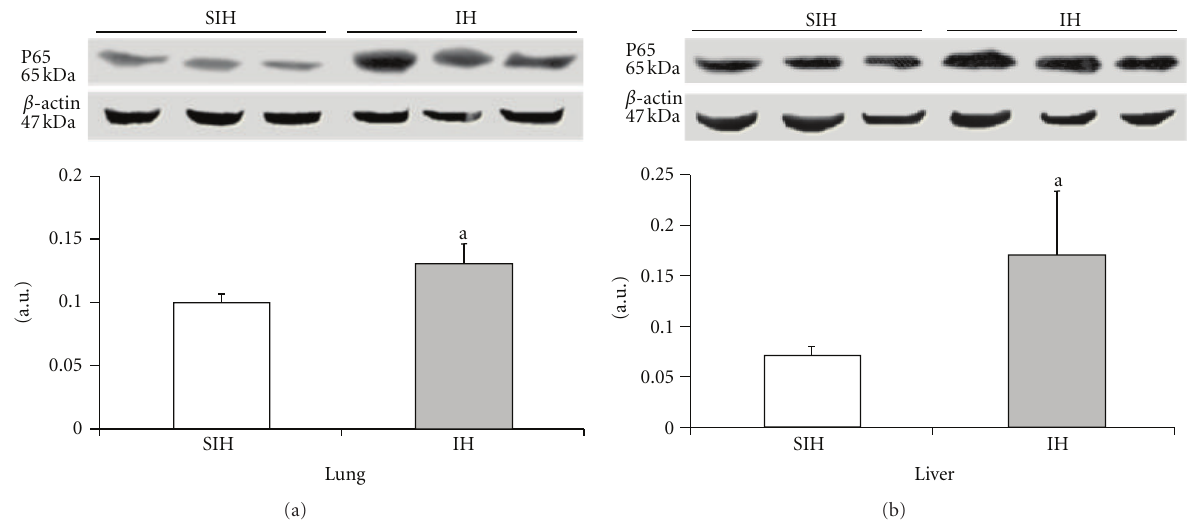
Figure 1: The e ff ect of intermittent hypoxia on the expression of phosphorylated NF- κ B in the liver ((a), P = 0 . 0247) and lung ((b), P = 0 . 0033). Results are reported as mean ± standard error, n = 6 per group. P value according to Student’s t